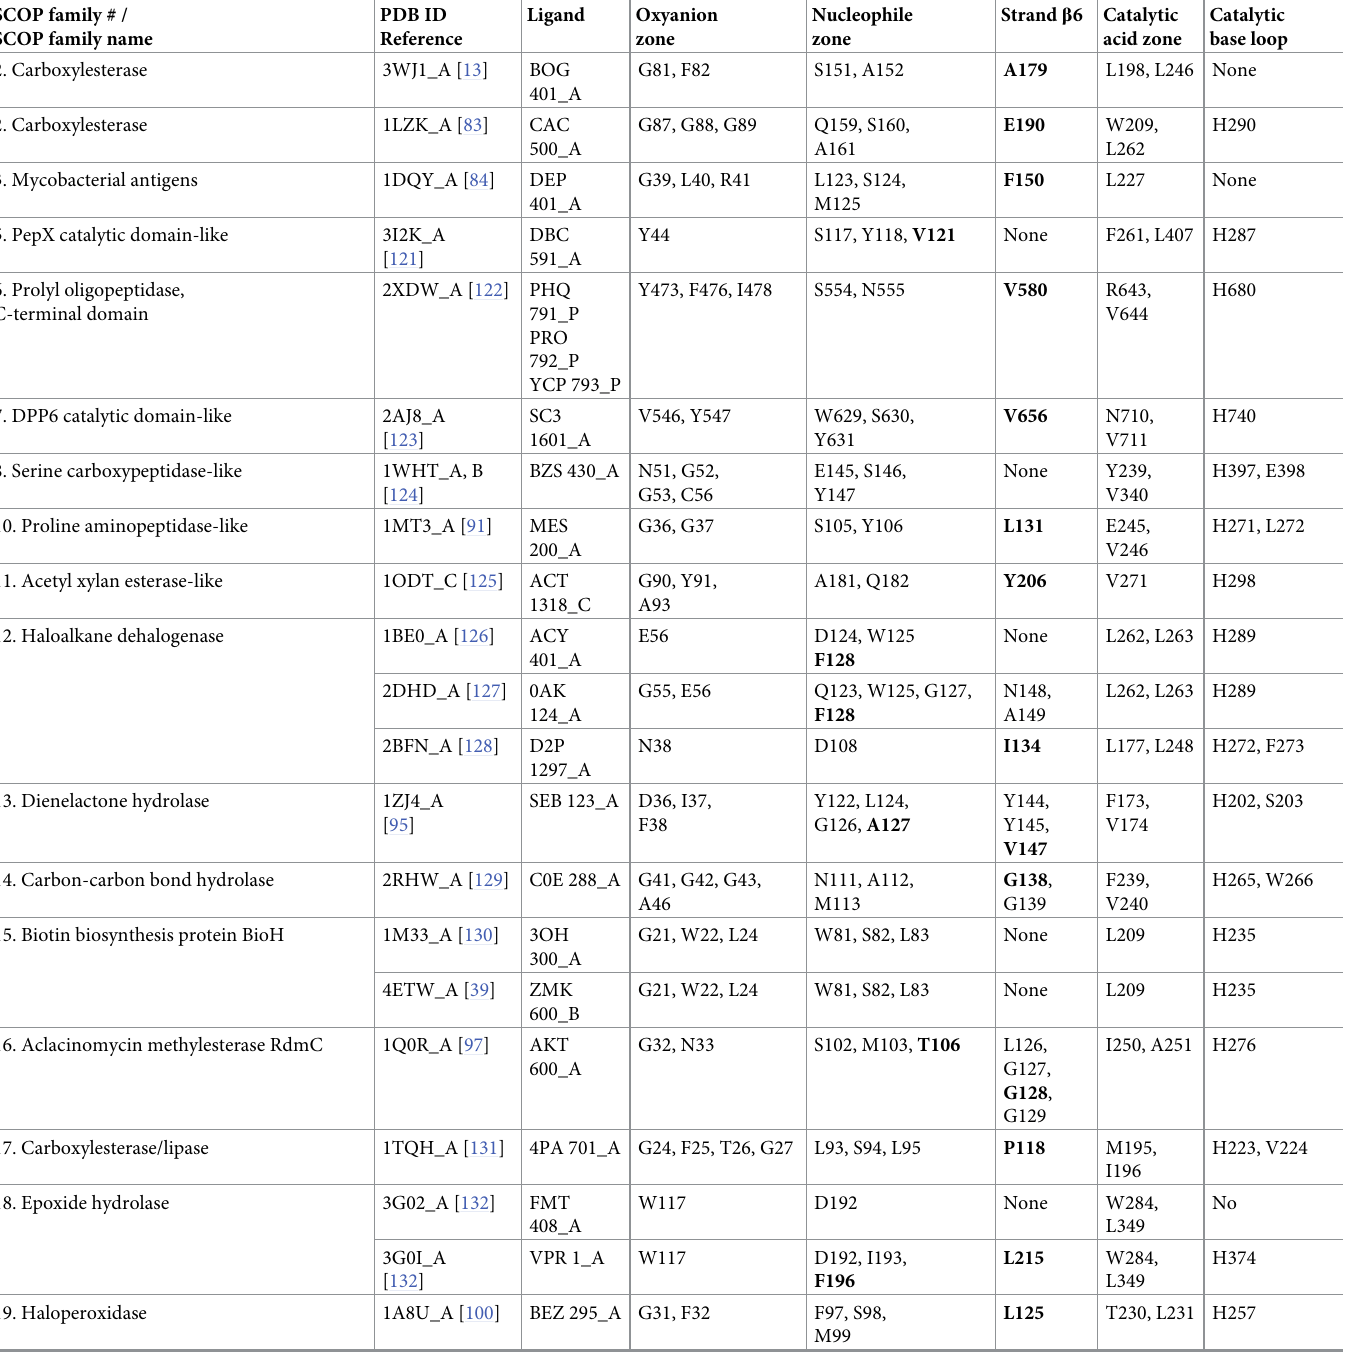
Table 2. Elements of the conserved catalytic structural core are involved in ligand binding in 28 ABH fold enzyme families. In ligand-bound represenative structures, the recognized substrate molecule (Ligand) frequently interacts with residues that belong to the conserved structural organizations of the ABH fold, including the oxyanion zone (Oxyanion zone), the nucleophile zone (Nucleophile zone), the C-terminal end of strand β 6 (Strand β 6) and the catalytic acid zone (Catalytic acid zone); residues from the loop that accommodates the catalytic histidine (Catalytic base loop) can also participate in ligand binding. Two ABH fold enzyme families (SCOP family #15 and SCOP family #18) are represented by two structures, each bound to a different substrate, while one ABH fold enzyme family (SCOP family #12) is represented by three rep- resentative structures that are bound to three different substrates. The first entry is for carboxylesterase SshEstI (SCOP family #2, PDB ID:3WJ1_A). Residues that are in bold signify that the specific residue does not belong to the conserved catalytic core, but are adjacent to it. Fields of the table that contain the entry “None” indicate that the corresponding geometry does not participate in ligand